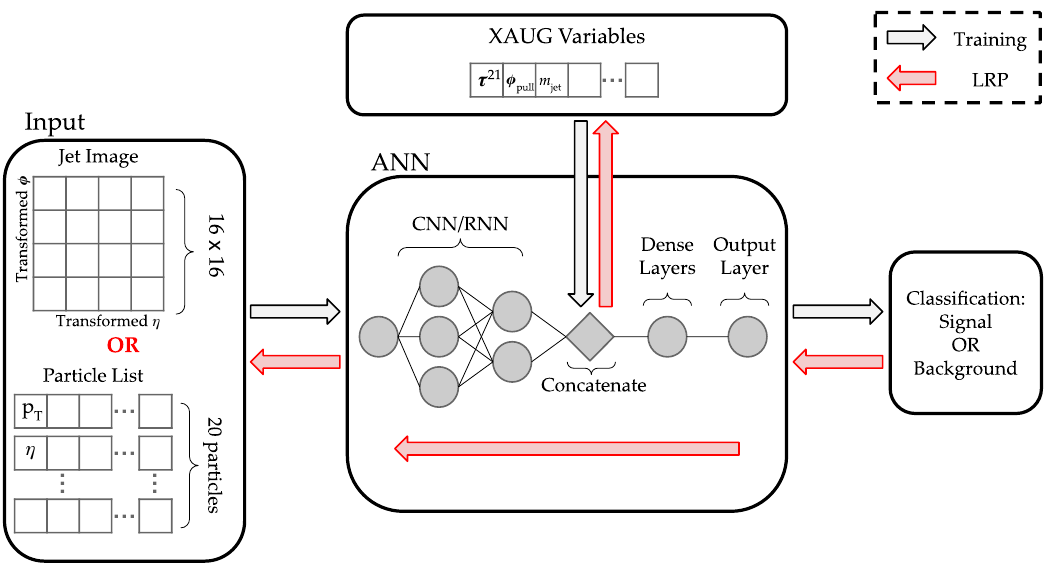
Figure 1. A schematic representation of our XAUG variables with LRP